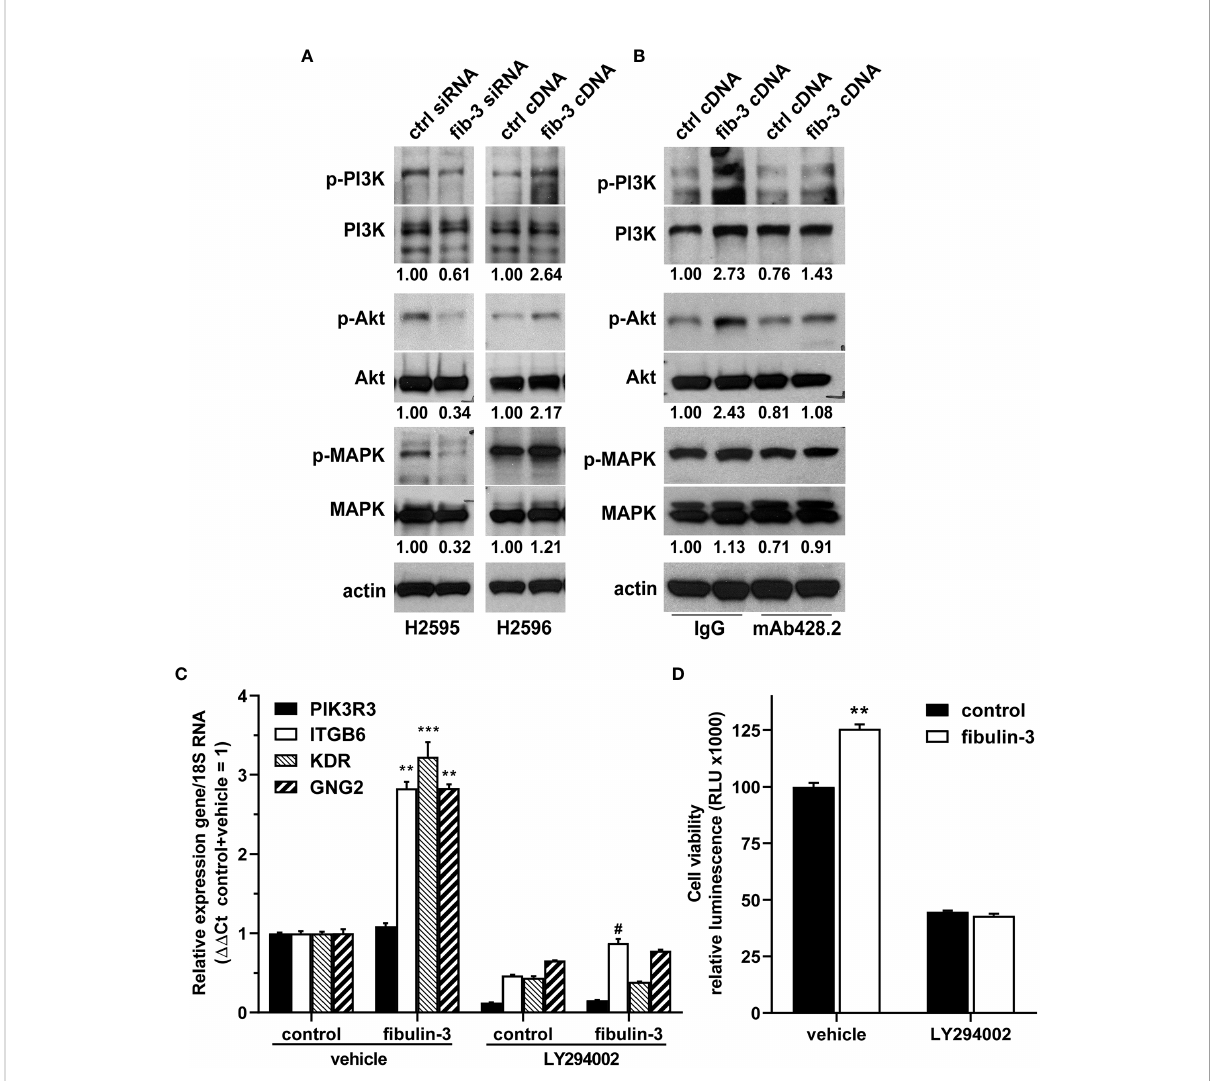
FIGURE 4 Fibulin-3 regulates PI3K/Akt signaling in MPM cells. (A) Transient knockdown of fi bulin-3 ( fi b-3 ) in H2595 cells decreased the phosphorylation of PI3K regulatory subunit (p85), Akt, and p38 MAPK. Conversely, transient overexpression of fi bulin-3 in H2596 cells increased the phosphorylation of PI3K and Akt (but had only minimal effect on MAPK). (B) The increased phosphorylation of PI3K/Akt by fi bulin-3 in H2596 cells was blocked with anti- fi bulin-3 mAb428.2 but not with a control antibody. The blots are representative images of experiments repeated in triplicate. The numbers under the blots represent the optical density ratio for the different phospho-bands referred to the control condition for each experiment (control = 1.00). Integrated optical density for each phosphoprotein was normalized to the total amount of that protein and to total actin used as loading control. Different pro fi les for total PI3K bands in panels (A) and (B) were the result of using different antibodies (Suppl. Table III). (C) Overexpression of fi bulin-3 cDNA in H2596 cells increased the expression of PI3K-dependent genes ( ** p<0.01; *** p<0.001 signi fi cant differences in absence of LY294002, two-way ANOVA). This effect was prevented by addition of the PI3K inhibitor LY294002 (# p<0.05 signi fi cant differences in presence of LY294002, two-way ANOVA). (D) Overexpression of fi bulin-3 increased the viability of H2596